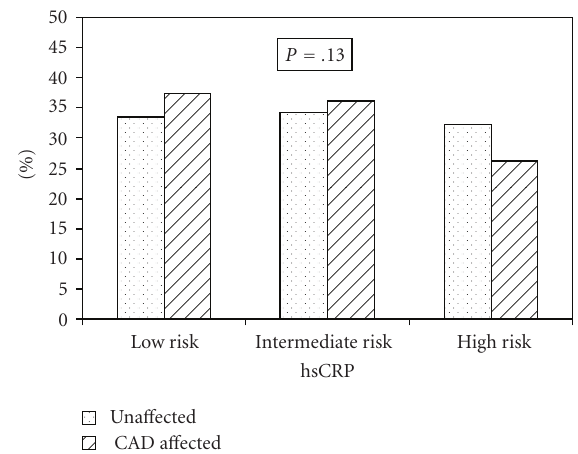
Figure 1: Classification of subjects based on high-sensitivity C-reactive protein (hsCRP) levels according to Joint American Heart Association and Centers for Disease Control and Prevention guidelines: low risk < 1 mg/L, moderate risk 1–3 mg/L, and high risk > 3mg/L. CAD = coronary artery